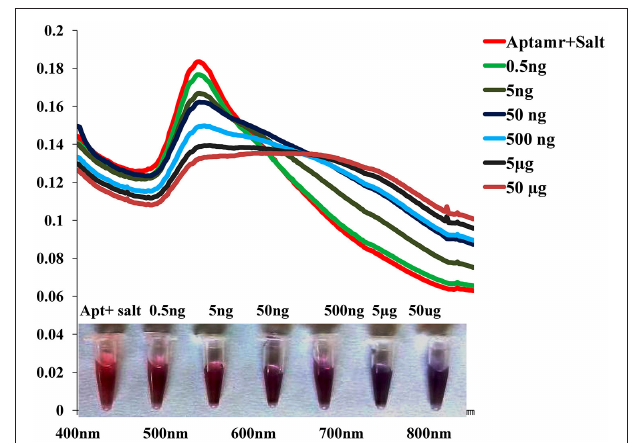
FIGURE 4 | Sensitivity of Gold nano particle based colorimetric detection assay. Absorption spectra of AuNPs/aptamer mixed solutions in the presence of various concentration of SEB.